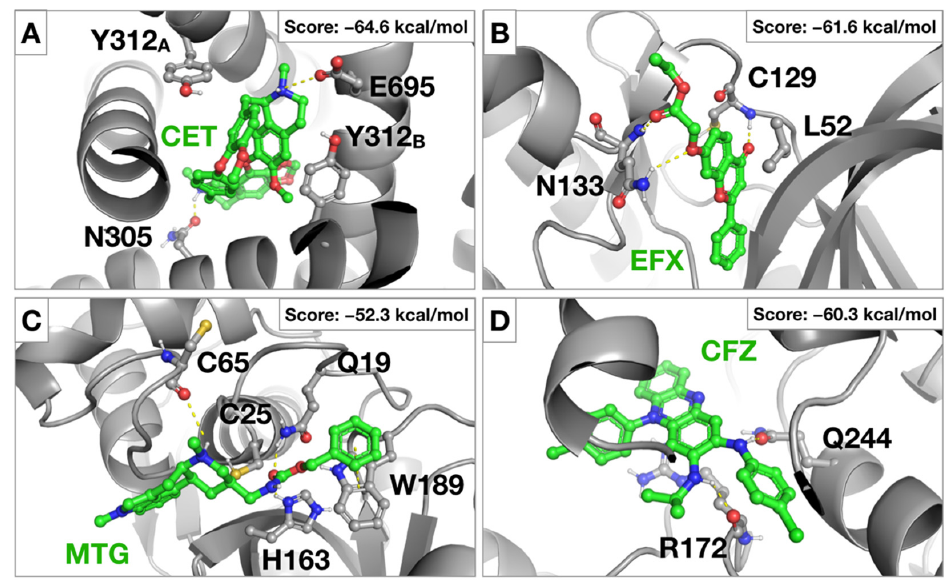
Figure 6. Binding modes and relative MMGBSA scores for ( A ) cepharantine (CET) in complex with TPC2, ( B ) efloxate (EFX) in complex with AAK1, ( C ) metergoline (MTG) in complex with cathepsin L and ( D ) clofazimine (CFZ) in complex with GAK.